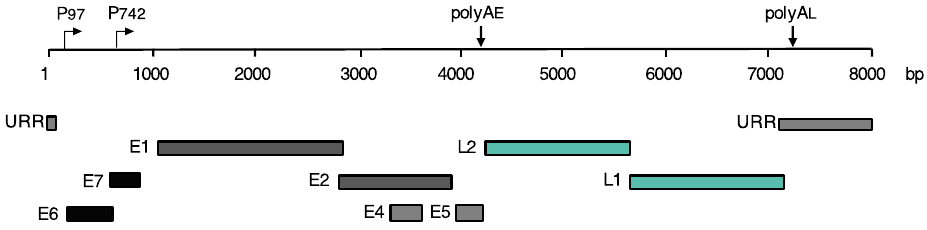
Figure 2. Linear representation of HPV31 DNA. The HPV genome is 8 kb in size and encodes eight viral gene products. The first genes transcribed are the E6 and E7 viral oncogenes, followed by the E1 and E2 replication proteins. E4 and E5 are typically expressed during the late stages of viral infection, along with the L1 and L2 capsid proteins. The early (p97) and late (p742) promoters, as well as the corresponding polyadenylation sites (polyA), are designated with arrows. URR: upstream regulatory region.